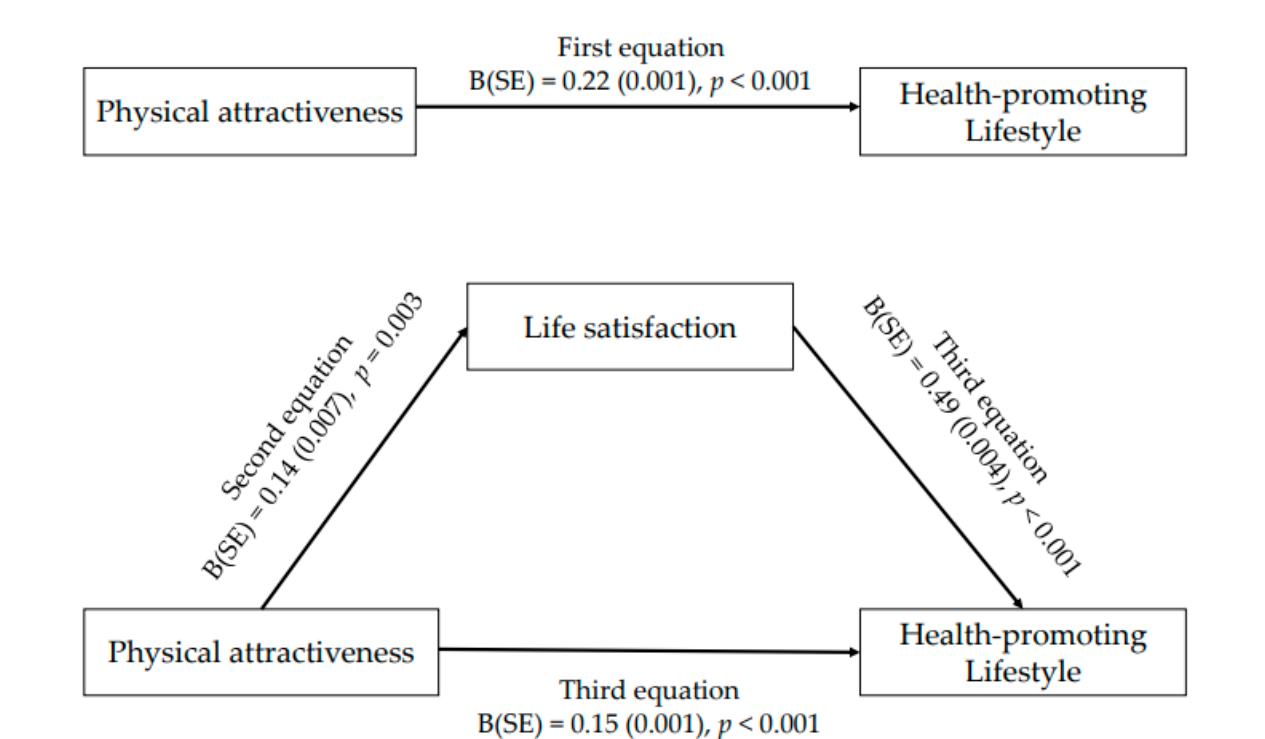
Figure 1. Testing for a mediating effect of life satisfaction on the association between physical attractiveness and health- promoting lifestyle.